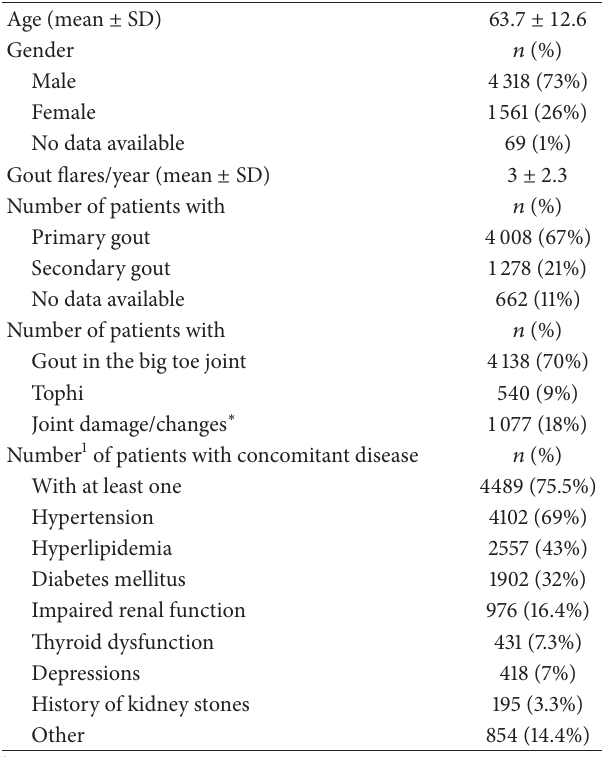
Table 1: Demographic and clinical data ( 𝑛 =